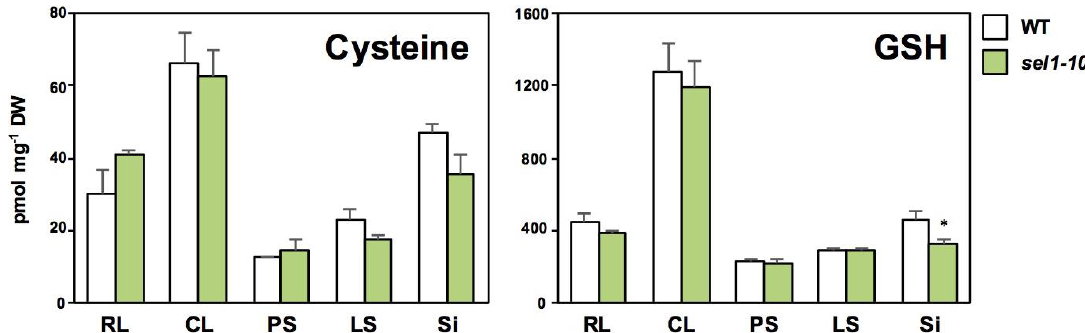
Figure 3. Cysteine and glutathione (GSH) concentrations in different parts of WT and sel1-10 plants. The cysteine and GSH contents of different parts were measured using HPLC-fluorescence detection. WT and sel1-10 seedlings were grown for 6 weeks in vermiculite, after which each part was harvested. Rosette leaves (RL), cauline leaves (CL), primary stems (PS), lateral stems (LS), and siliques (Si). White and green bars represent cysteine and GSH levels in WT and sel1-10 plants, respectively. Data are shown as the averages with error bars denoting SEM (n = 3). Asterisks indicate significant differences (Student’s t -test; * 0.05 < p <0.1, ** p < 0.05) between WT and sel1-10 plants.